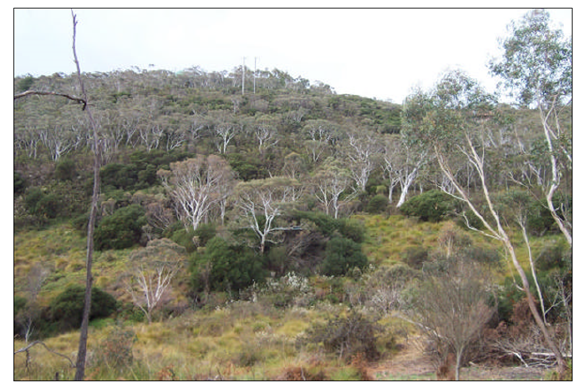
Figure 1. Heathland environment with multistemmed mallee in the Blue Mountains, New South Wales, Australia